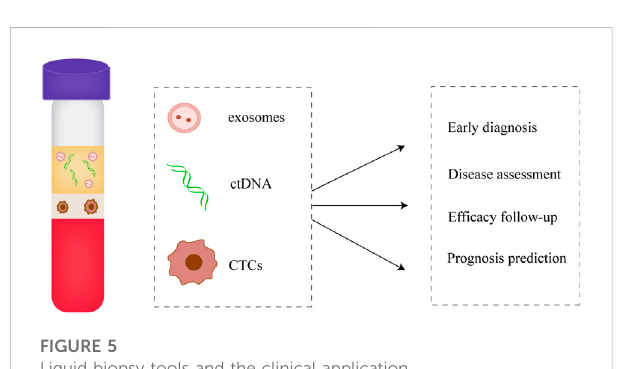
(Figure 5). CTC and ctDNA are now commonly used in clinical practice.